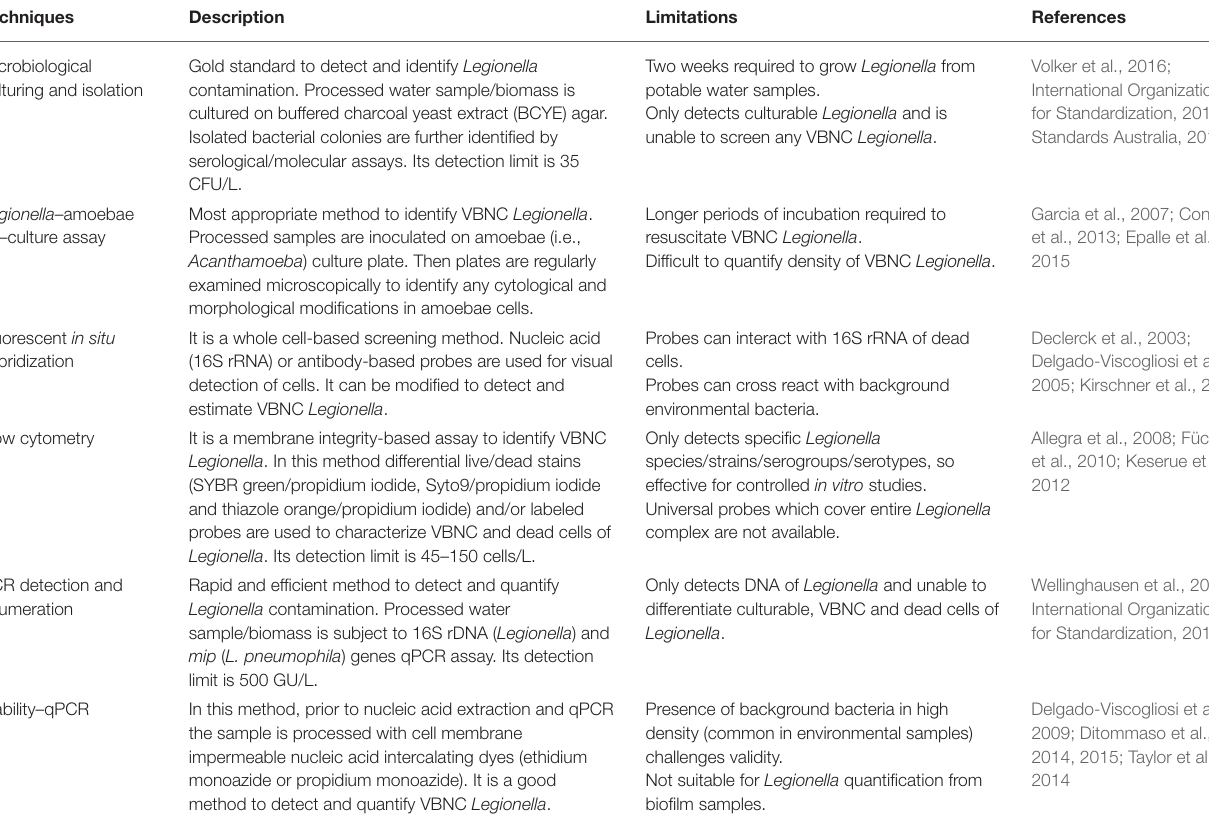
TABLE 2 | Methods available for screening and detection of Legionella contamination from potable water and building plumbing